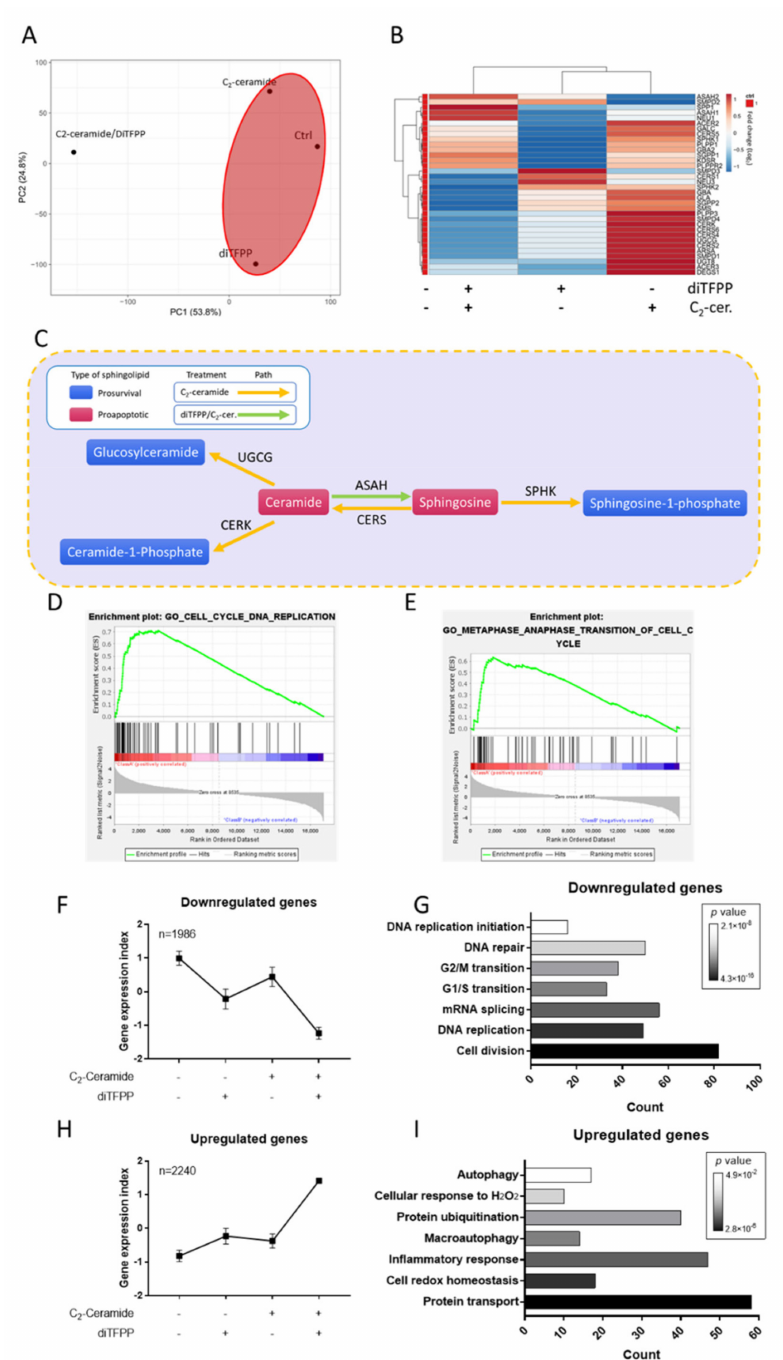
Figure 3. NGS analysis of diTFPP/C 2 -ceramide treatment indicating the alteration of sphingolipid metabolism and the potential regulatory mechanisms. ( A ) PCA of the four treatment groups. ( B ) The expression of sphingolipid metabolic genes after 24 h of 10 µ M diTFPP and/or 20 µ M C2-ceramide (C 2 -cer.) treatment. ( C ) Schematic diagram of sphingolipid metabolic alteration. ( D and E ) GSEA of differences in the biological processes (BP) between C 2 -ceramide (Class A)- and C 2 -ceramide/diTFPP (Class B)-treated cells. ( F ) Alterations in the expression pattern of downregulated genes after diTFPP/C2-ceramide treatment, with average expression set as 0 and the standard deviation set as 1. ( G ) GO term analysis of downregulated genes after diTFPP/C2-ceramide treatment. ( H ) The expression alteration of upregulated genes after diTFPP/C2-ceramide treatment, with average expression set as 0 and the standard deviation set as 1. ( I ) GO term analysis of upregulated genes after diTFPP/C2-ceramide